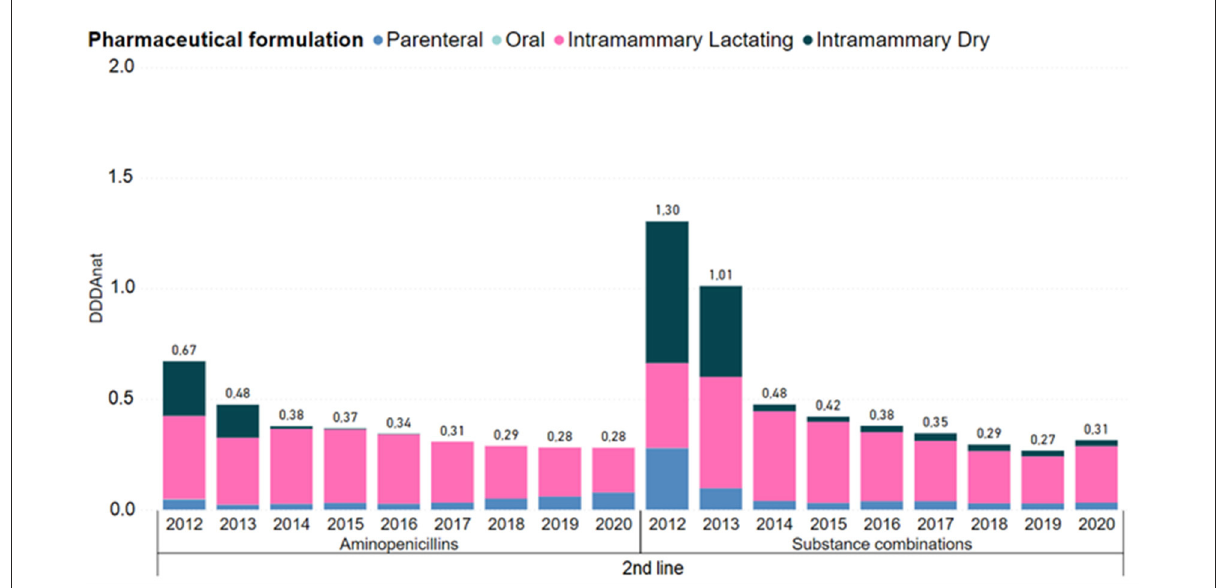
FIGURE5 Antimicrobial consumption in the Dutch dairy sector of 2nd line products, in DDDA NAT units, from 2012 to 2020, segmented into the different pharmaceutical formulations. Aminoglycosides, cephalosporins 1st and 2nd gen, long-acting macrolides, polymyxins and quinolones were left out because each group represented < 5% of the use in this line of choice. Full graph can be consulted in the Supplementary